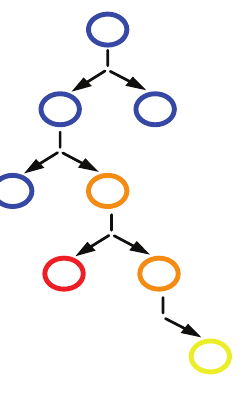
Figure 1. Stem cell self-renewal process, where the color circles shows the stem cell and the yellow circle is the best stem cell in the final iteration when the algorithm convergences to optima.